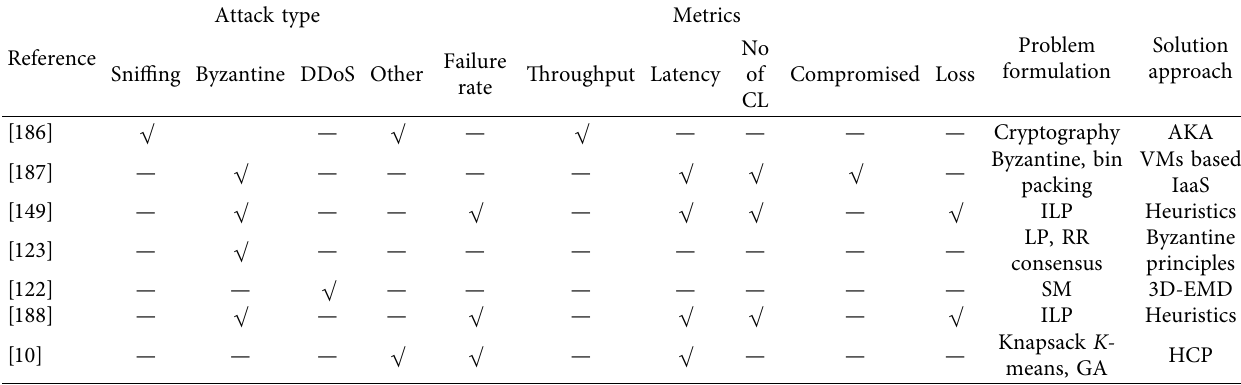
Table 10: Comparison of related works on dmCP